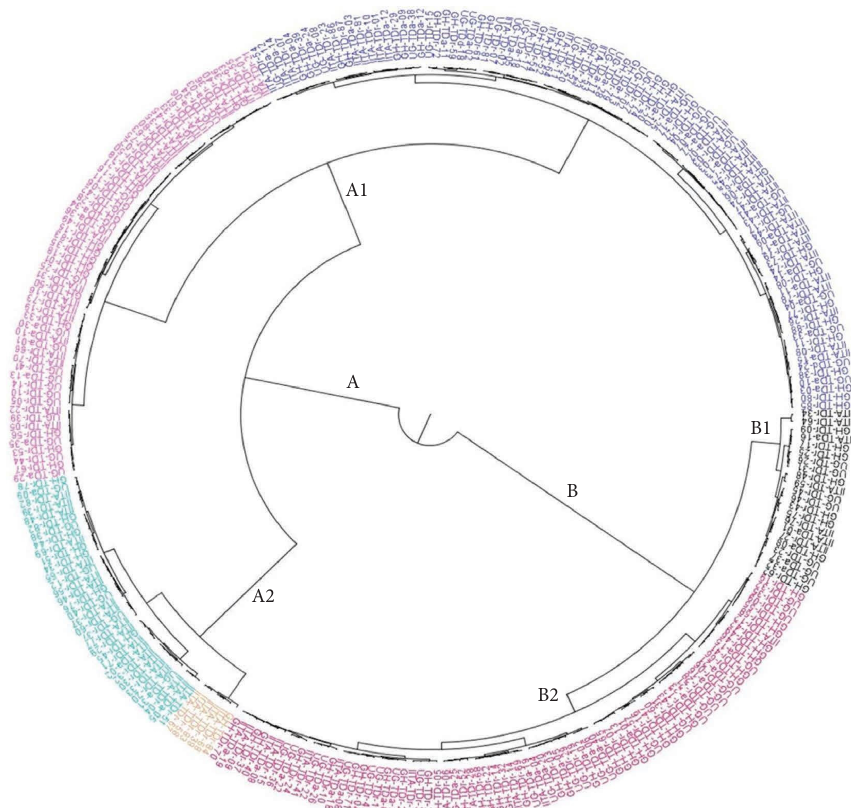
Figure 6: A dendrogram showing diversity among 291 yam genotypes based on phenotypic